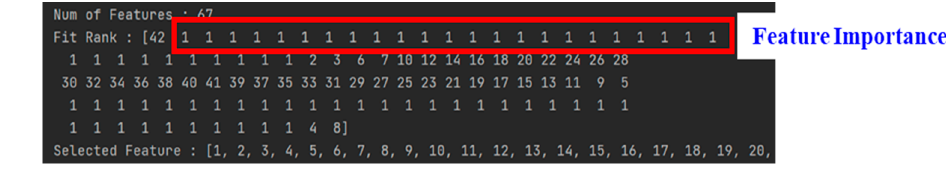
Table 3. Rank 1 extraction according to feature importance.